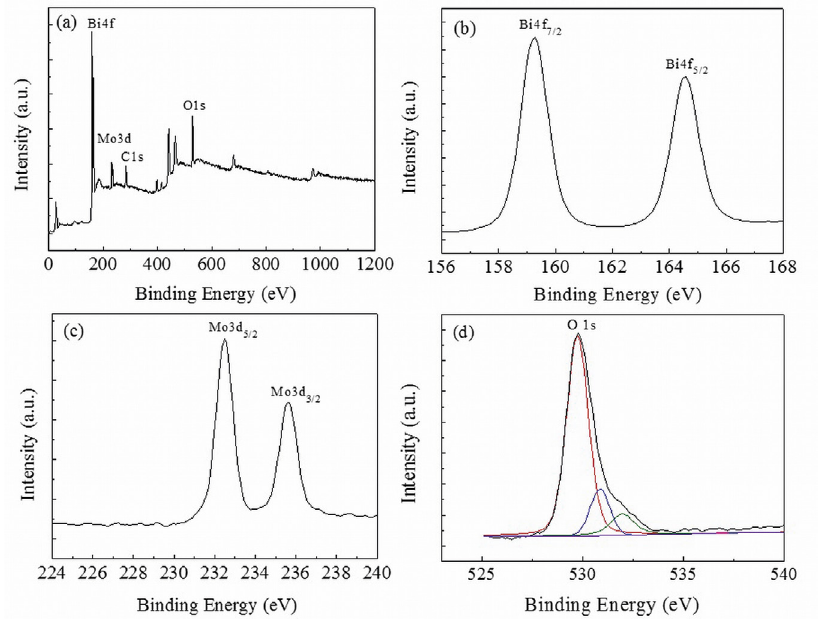
MoO sample: (a) wide scan spectra, (b) Bi4f spectra, (c) Mo3d 2 6